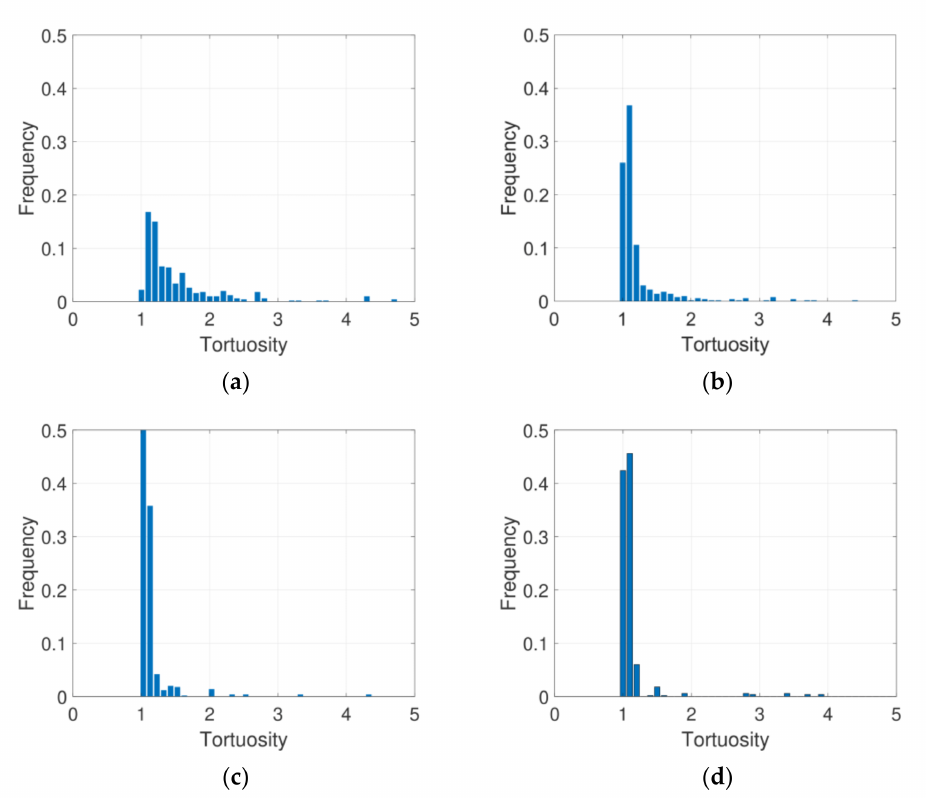
Figure 10. Tortuosity distribution of each specimen: ( a ) G33, ( b ) G47, ( c ) G60, and ( d ) G72.